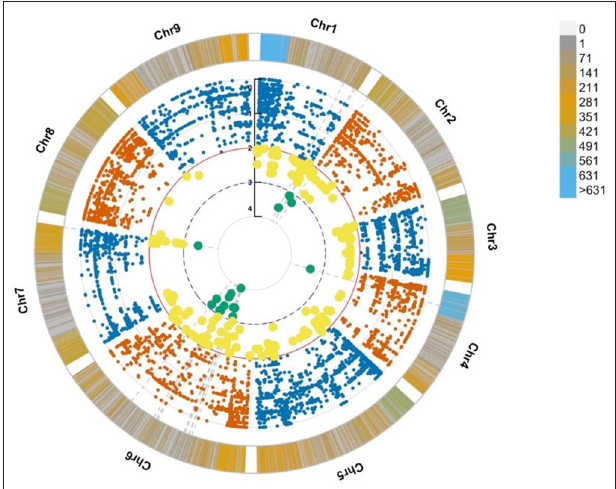
FIGURE 3 | Circular Manhattan plot from association analyses showing SNP density per chromosome along with significant SNP associations. The bars along the chromosomes present the SNP density in a window size of 10M base pairs. The most significantly associated SNPs are highlighted in yellow ( p ≤ 0.01) and cyan ( p ≤